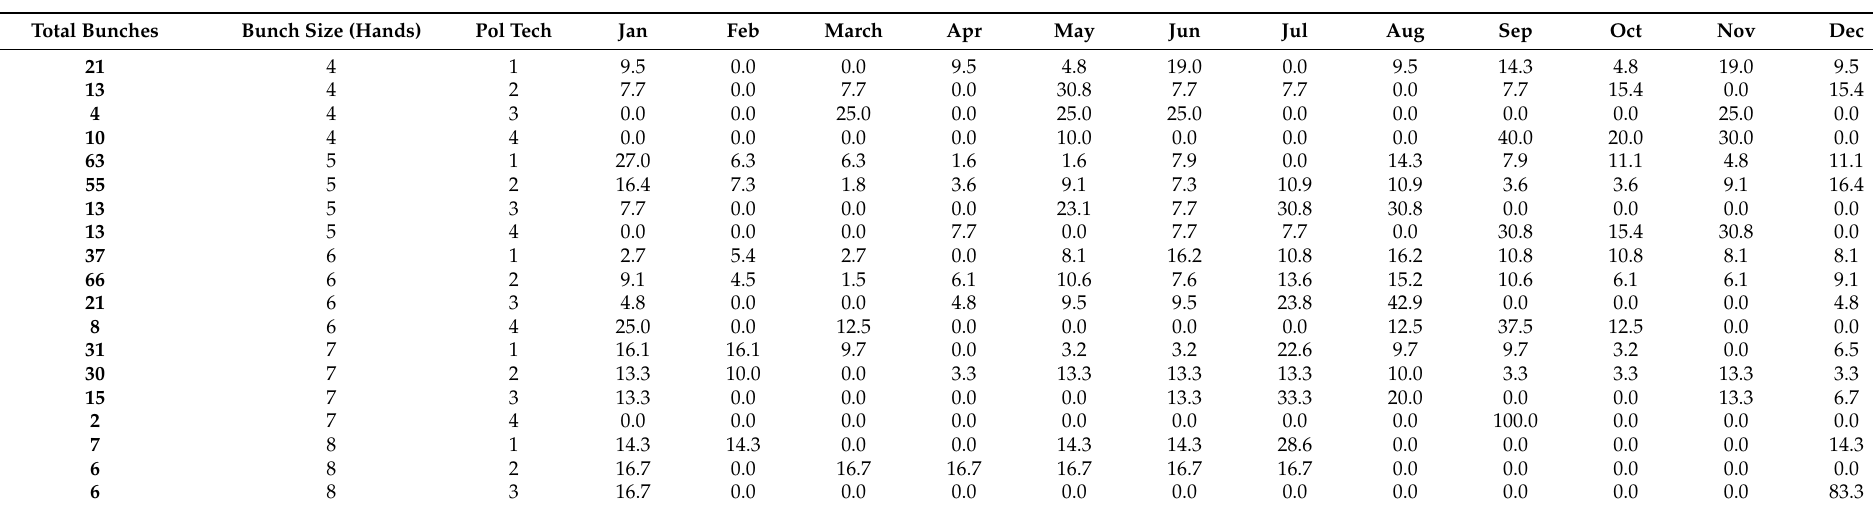
Table A5. Percentage bunch distribution by month of pollination in “Enzirabahima”, pollinated with “Calcutta 4”, using different pollination techniques, between January 2016 and